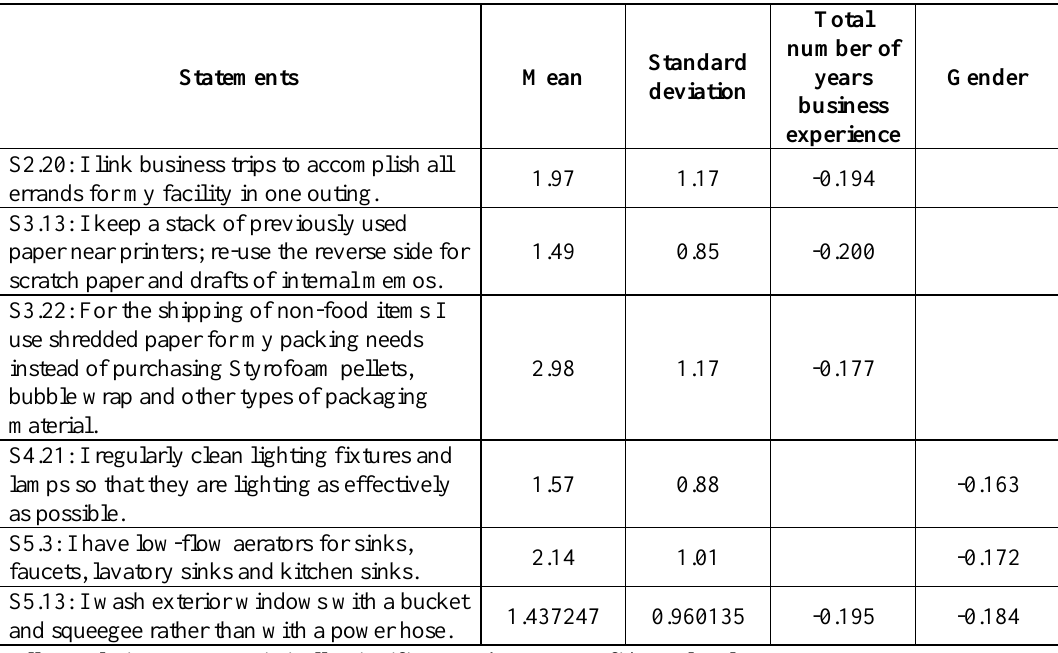
Table 6: Correlations between “green” actions and respondents’ biographical